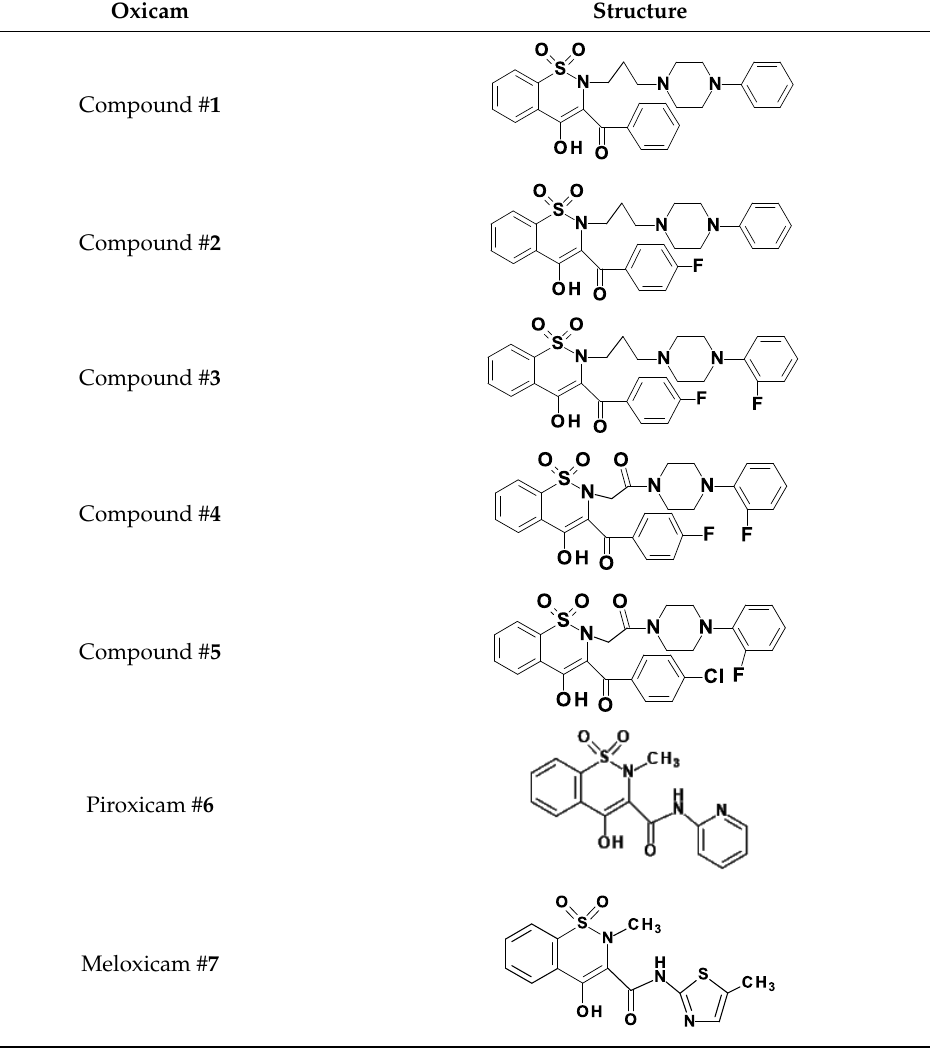
Table 2. Chemical structures of examined oxicams.